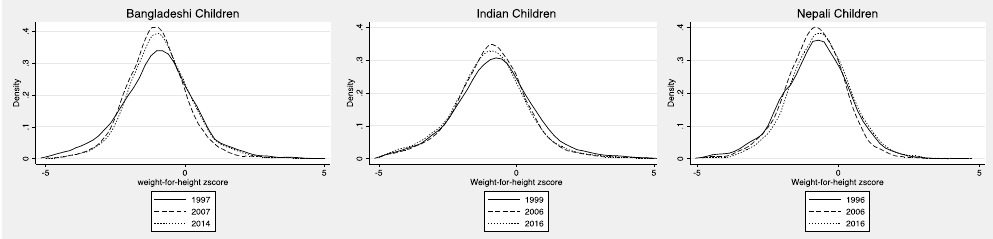
Figure 1. Distribution of weight-for-height z -score (WHZ) of children 0 to 59 months of age in Bangladesh, India and Nepal over time.